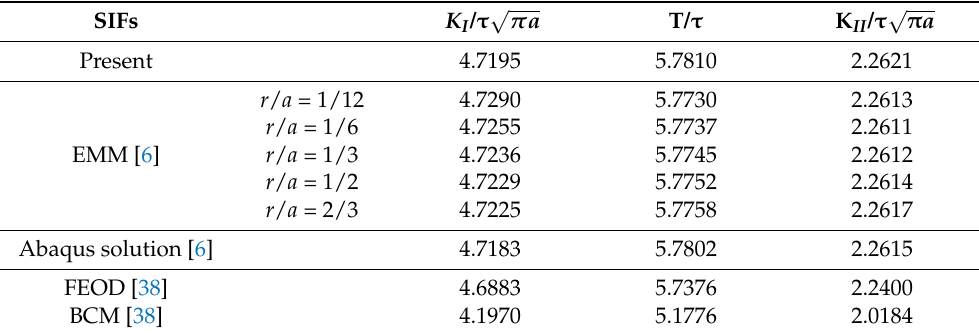
Table 3. Normalized SIF for a slanted-edge crack plate under end